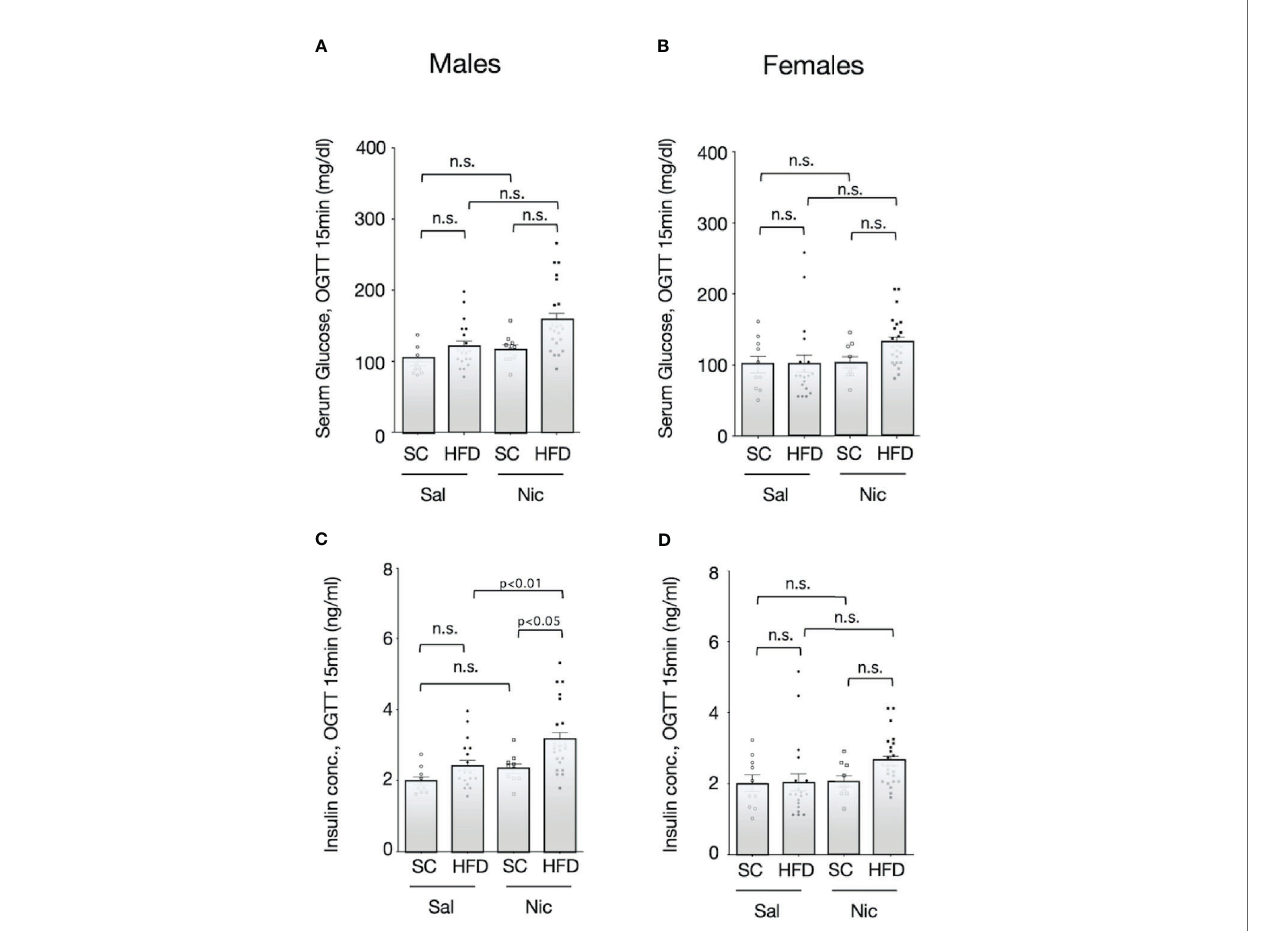
FIGURE 4 | Blood sugar and insulin levels after oral glucose challenge. Blood samples were collected 15 min after glucose solution (2g/100g b.w.) ingestion. Their plasma concentrations of glucose ( A for males and B for females) and insulin ( C for males and D for females) of standard chow-fed (SC) offspring or high fat diet (HFD)-exposed offspring from nicotine-administered dams (NIC) or saline-treated dams (Sal) were measured. Values are presented as means ± SEM. Statistical analysis was performed using one-way ANOVA followed by Tukey ’ s post hoc test for multiple comparisons. n.s., not signi fi cant (p ≥